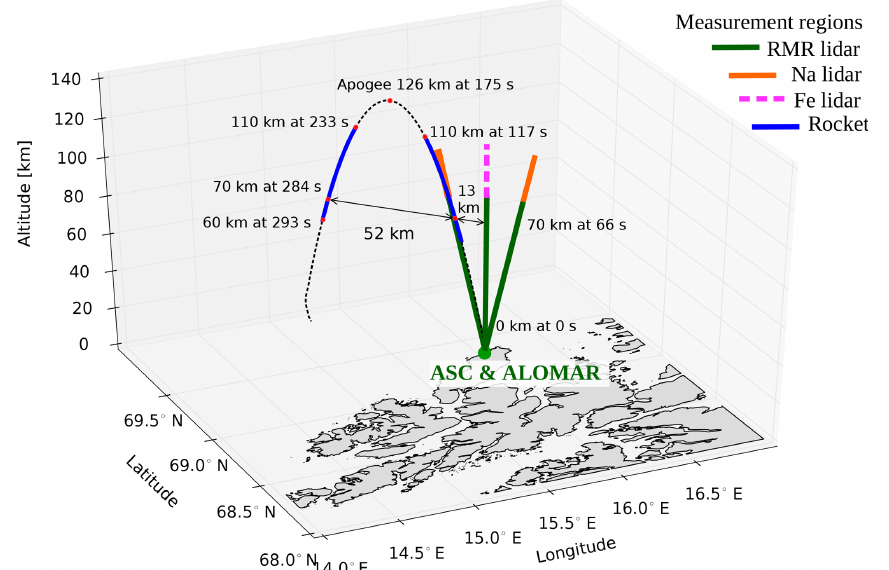
Figure 1. Schematics of the WADIS-2 rocket experiment. Solid green and orange and dashed magenta lines show ALOMAR RMR, Na, and IAP Fe lidar measurement volumes, respectively. The black dashed line shows the rocket trajectory. Blue lines show the rocket measurement range used in this